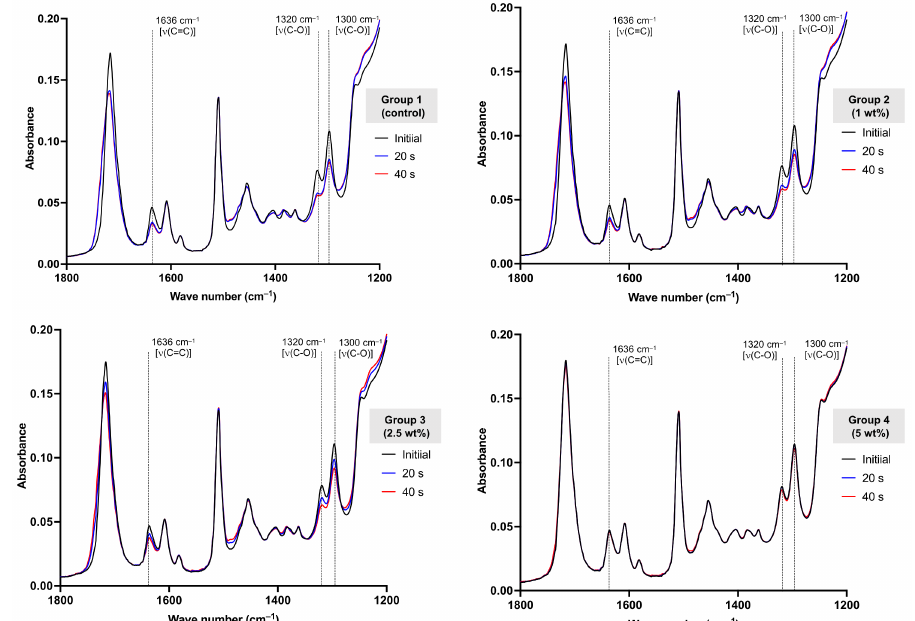
(Table 2). Group 4 showed the lowest degree of monomer conversion at 20 (3.3 ± 3.7%) and 40 s (7.9 ± 7.6%).